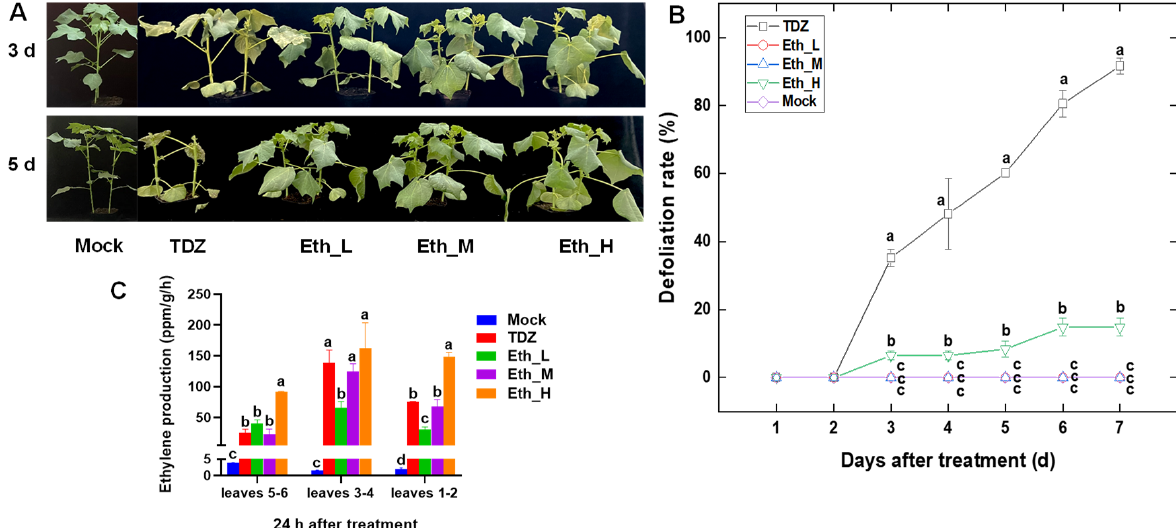
Figure 1. Effect of thidiazuron (TDZ) and ethephon (Eth) on cotton leaf defoliation and ethylene production. ( A ) Representative plants at 3 d and 5 d after treatment with 300 mg/L TDZ, or ethephon with 0.2 (Eth_L), 0.6 (Eth_M), and 1.2 (Eth_H) mg/L. ( B ) Defoliation rate (%) over time after treatment. ( C ) Ethylene production of upper (5-6), middle (3-4), and lower (1-2) leaves at 24 h after treatment. Error bars represent the SD of three biological replicates. Homogeneous subgroups with significant differences ( p ≤ 0.05) are marked by different lowercase le tt ers.